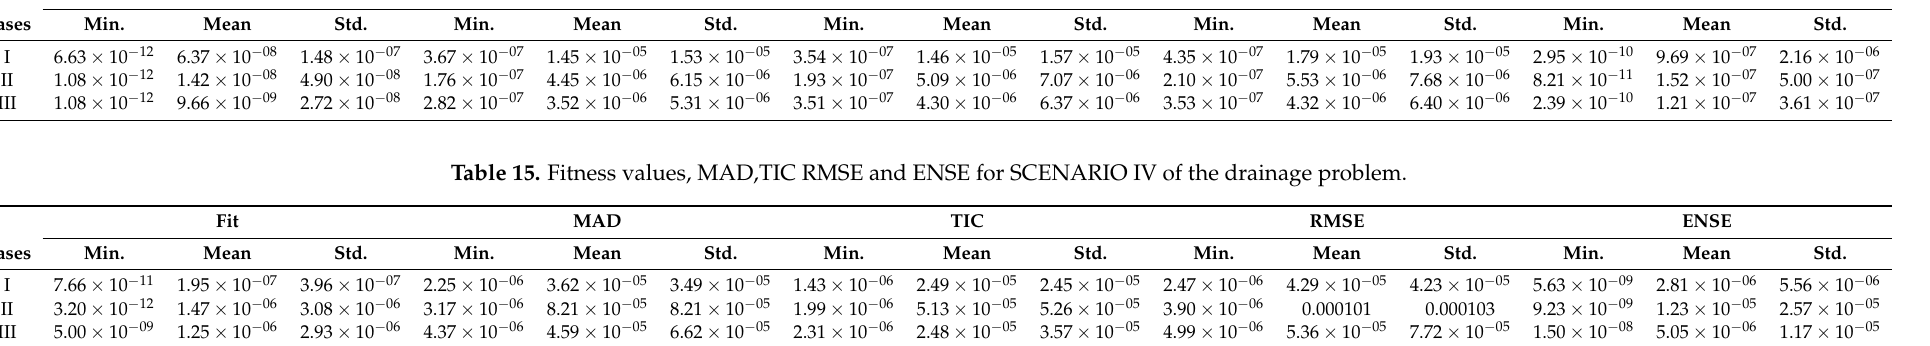
Table 14. Fitness values, MAD,TIC RMSE and ENSE for SCENARIO III of the drainage problem. MAD TIC RMSE ENSE Std. Min. Std. Min. Std. Min. Std.